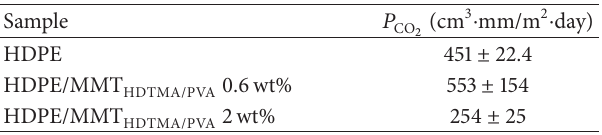
Table 3: CO permeability of HDPE and HDPE/MMT 2 (0.6wt% and 2 wt%).